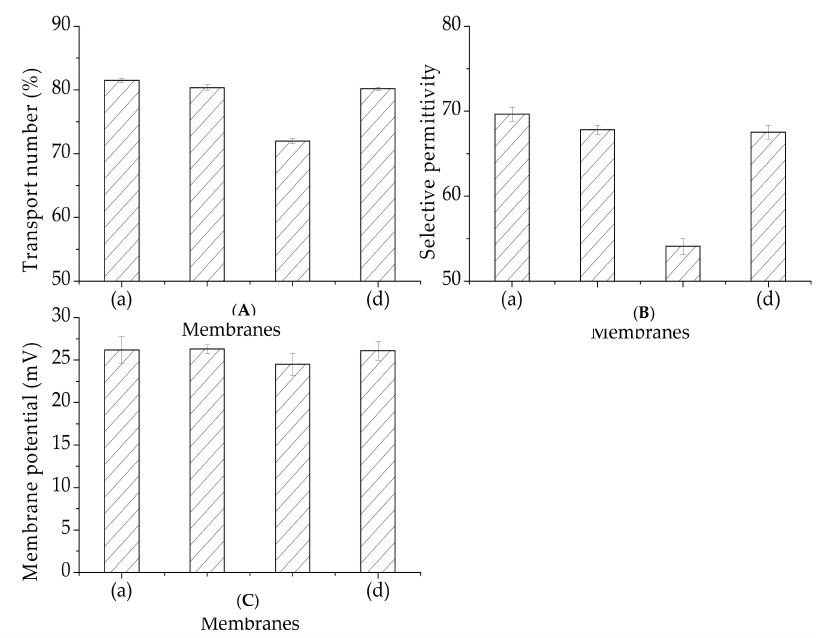
Figure 10. ( A ) Membrane potential, ( B ) transport number, and ( C ) permselectivity for ( a ) PVDF-SiO 2 -4, ( b ) PVDF-SiO 2 -6, ( c ) PVDF-SiO 2 -8, and ( d ) Ionsep-HC-C